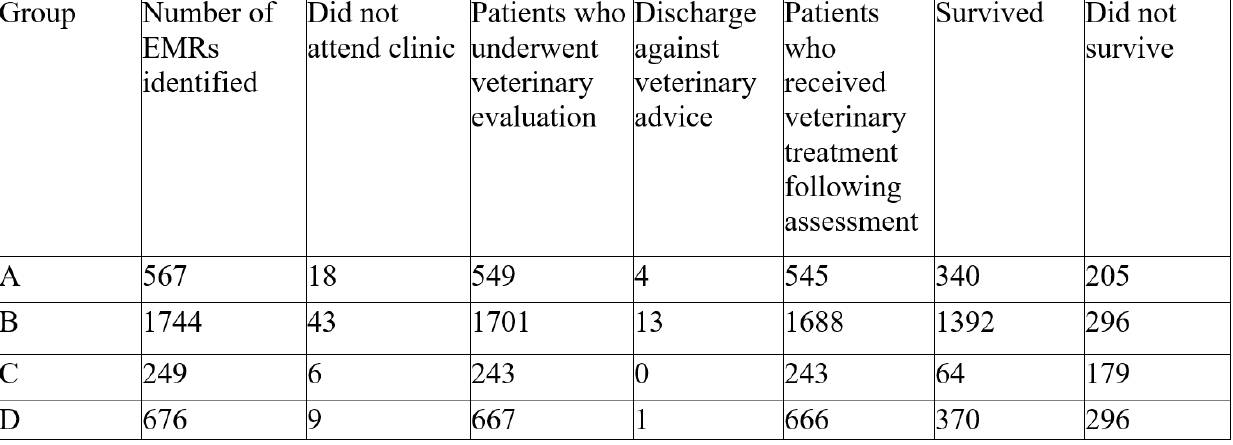
Table 1: Outcome recorded for all canine/feline patients whose owners contacted the out-of-hours clinics for advice.